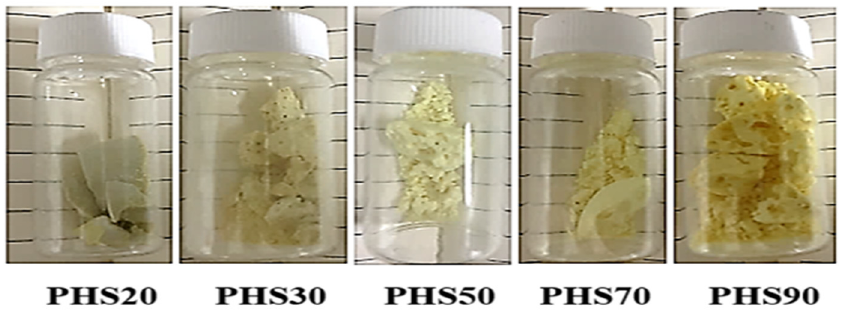
Figure 1. Synthesis of PHS(20–90) copolyesters.